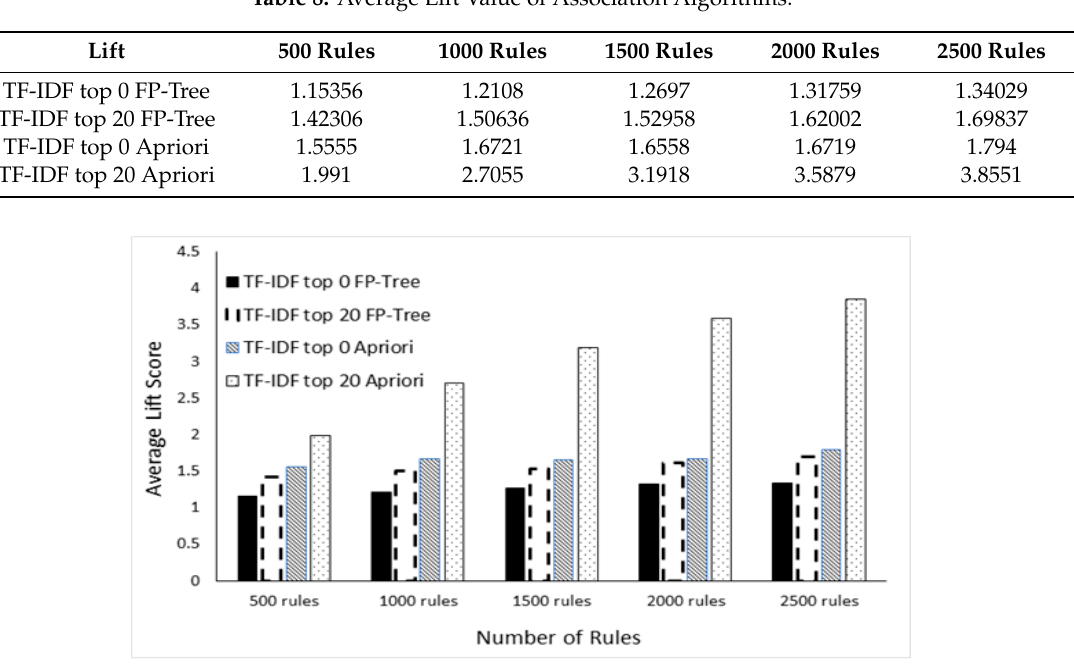
Table 8. Average Lift Value of Association Algorithms.